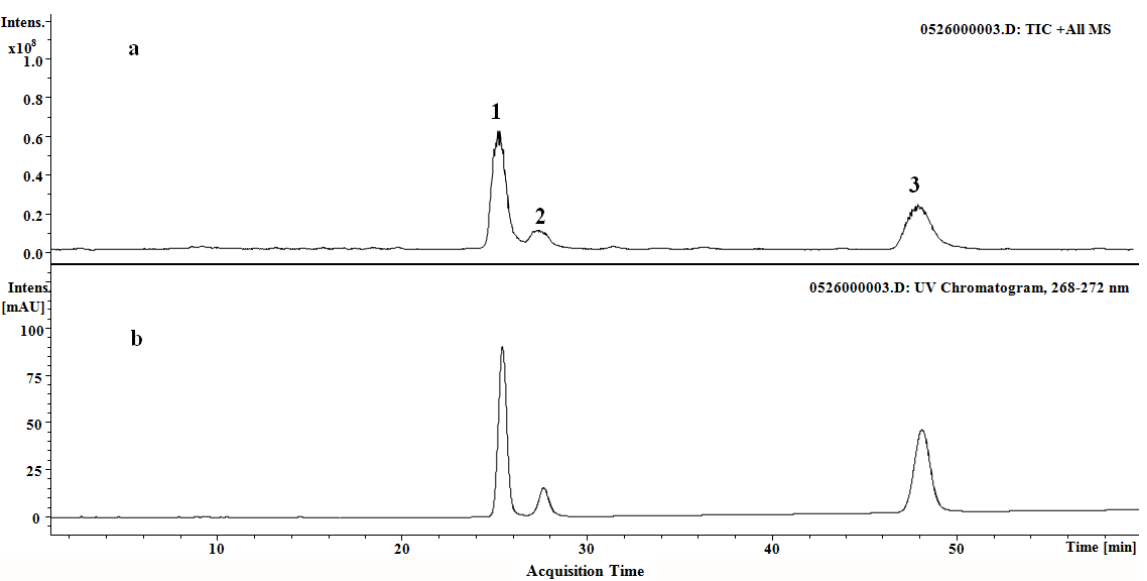
Figure 3. ( a ) TIC chromatogram in positive ion mode. ( b ) HPLC-DAD chromatogram at 47.1